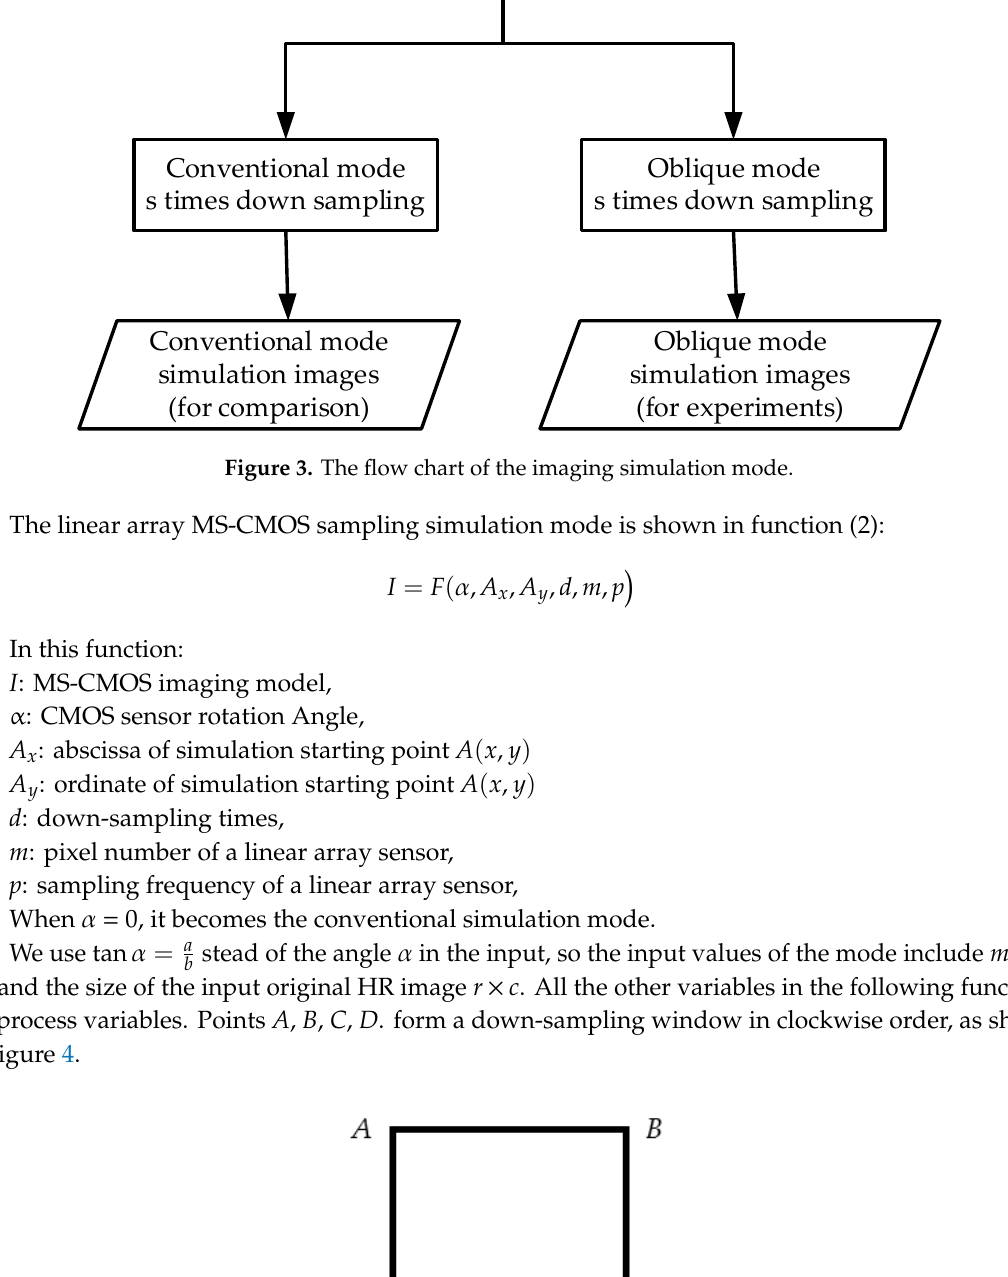
Figure 3. The flow chart of the imaging simulation mode.